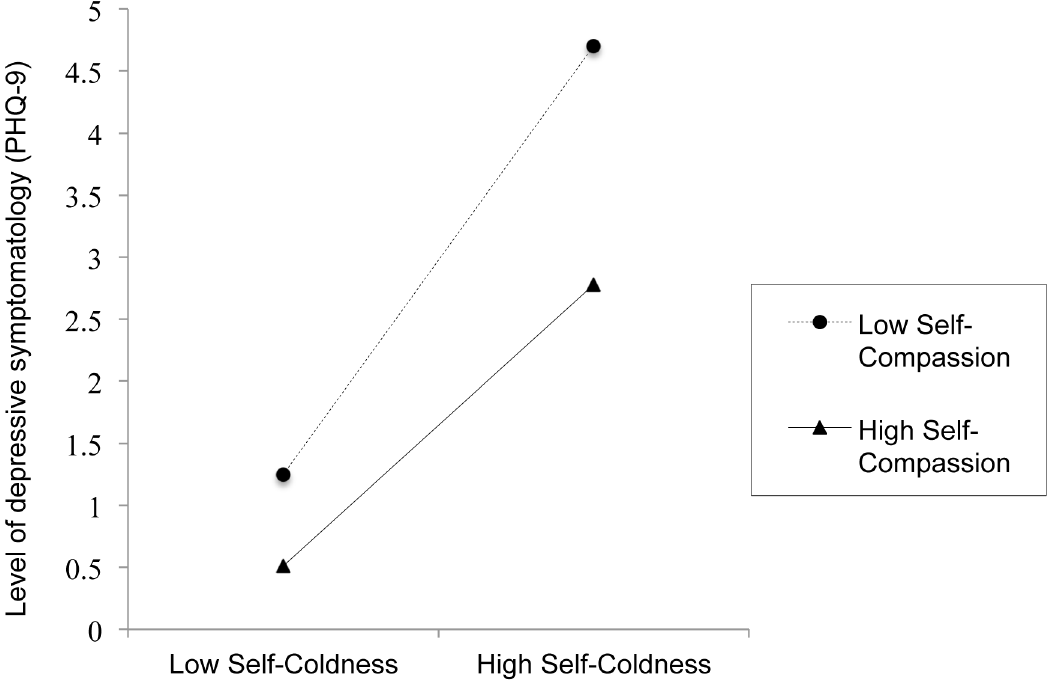
Fig 1. Illustration of the moderation of the relationship between self-coldness and depression by self-compassion (n = 2,404).